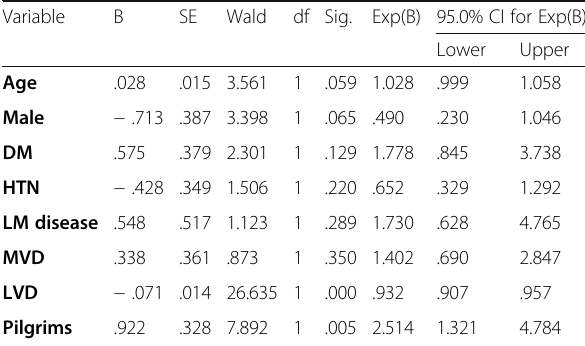
Table 4 Cox regression analysis of in-hospital mortality